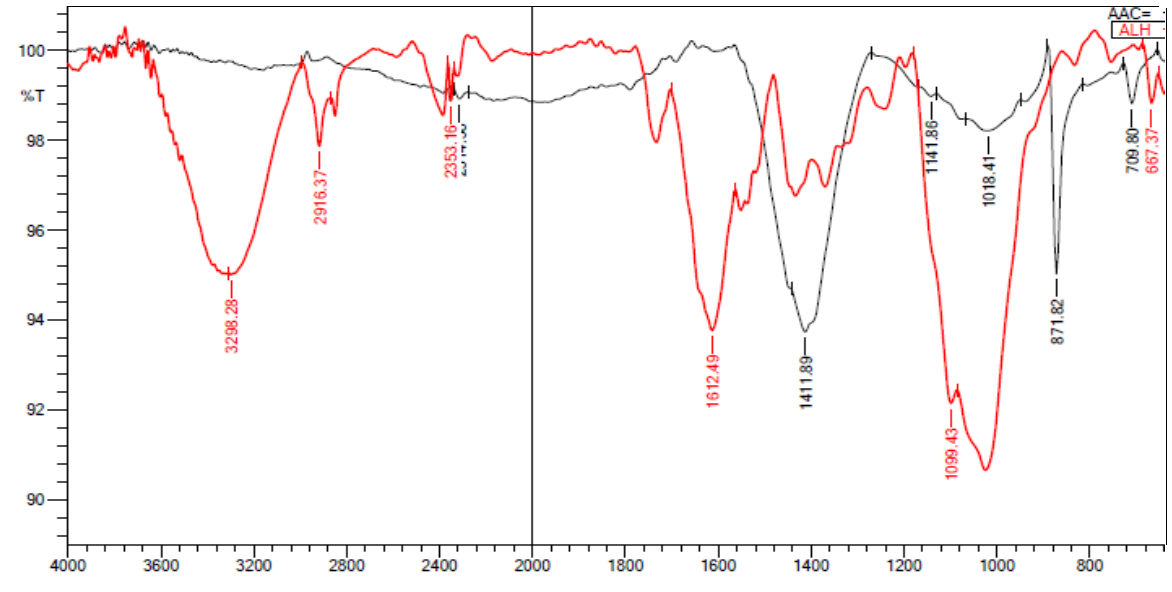
Fig. 4. FTIR spectra of Alhagi plant (ALH) and Alhagi activated carbon (AAC).